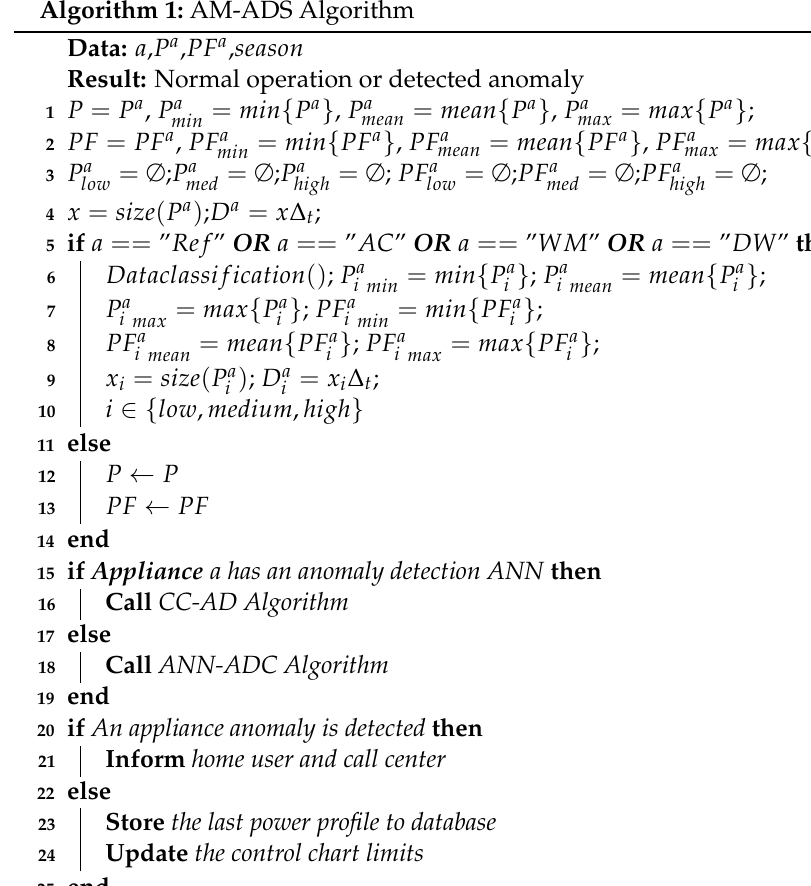
Algorithm 1: AM-ADS